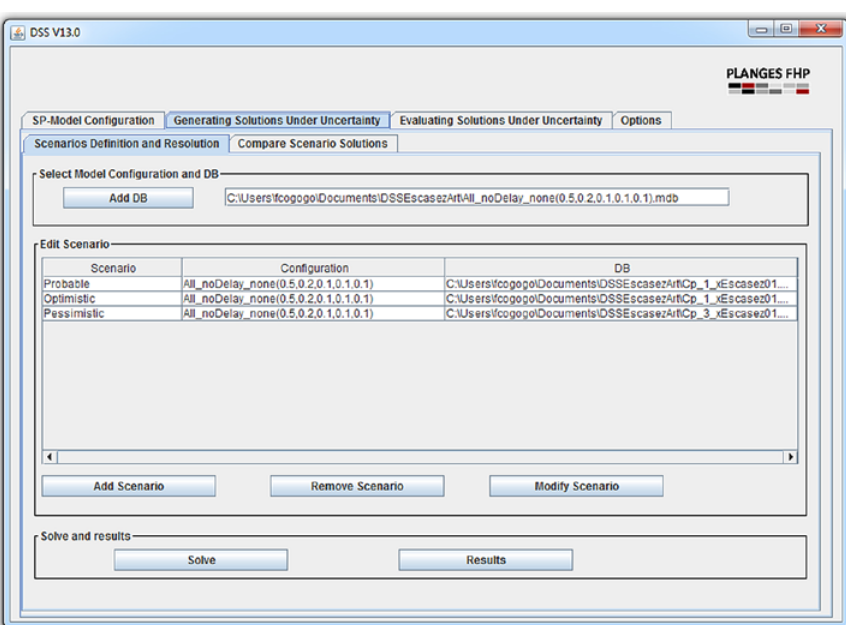
Fig. 5. The “Scenario Definition and Resolution” DSS